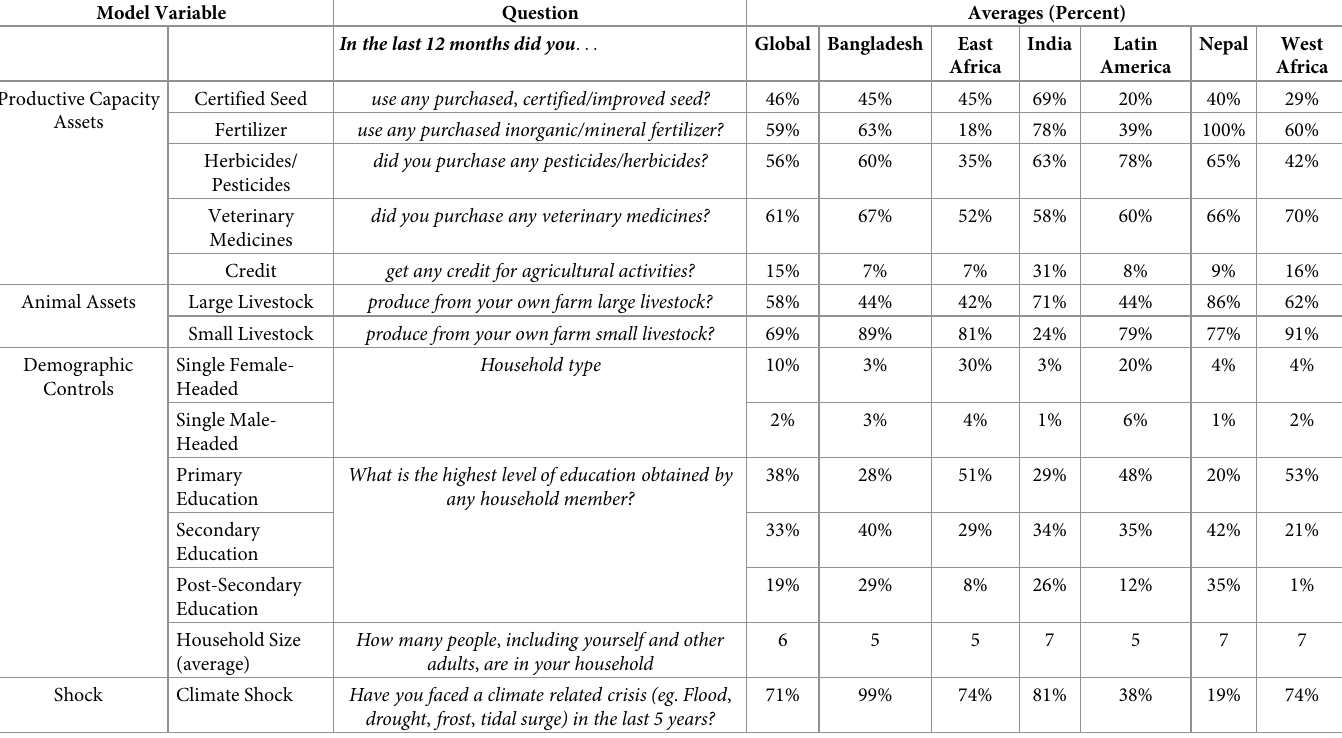
Table 1. Asset and demographic control variables in models. Regional designations are made based on aggregating sites and countries geographically, and also on dif- ferences in food insecurity and predictor variables (col. 1). Bangladesh, India, and Nepal are reported as separate regions. Note that some regions contain only one site. Model